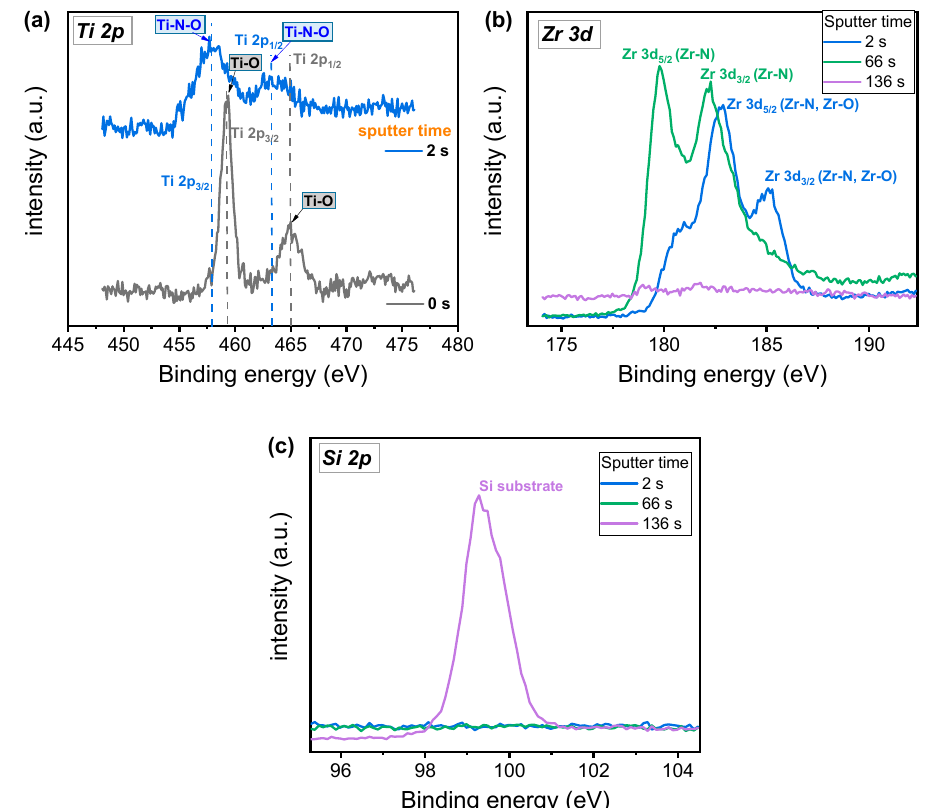
Figure 1. XPS spectra of ( a ) Ti 2p, ( b ) Zr 3d, and ( c ) Si 2p obtained by TiO 2 /ZrO 2 /Si depth profile.